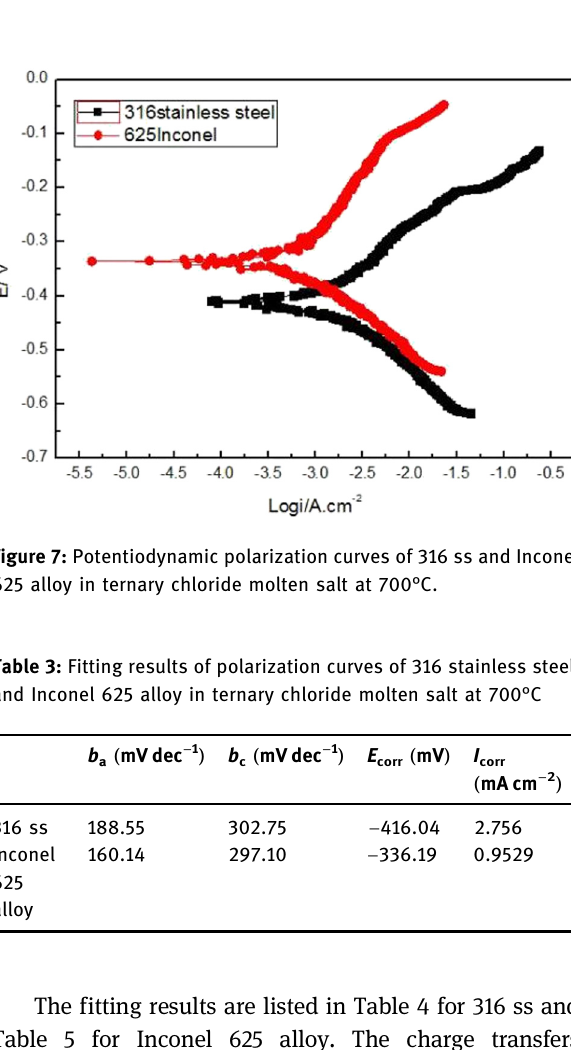
The fitting results are listed in Table 4 for 316 ss and Table 5 for Inconel 625 alloy. The charge transfers ) is the rate - limiting process in the melts. resistance ( R t for Inconel 625 in the melt are larger than The values of R t 316 ss, suggesting better corrosion resistance of Inconel